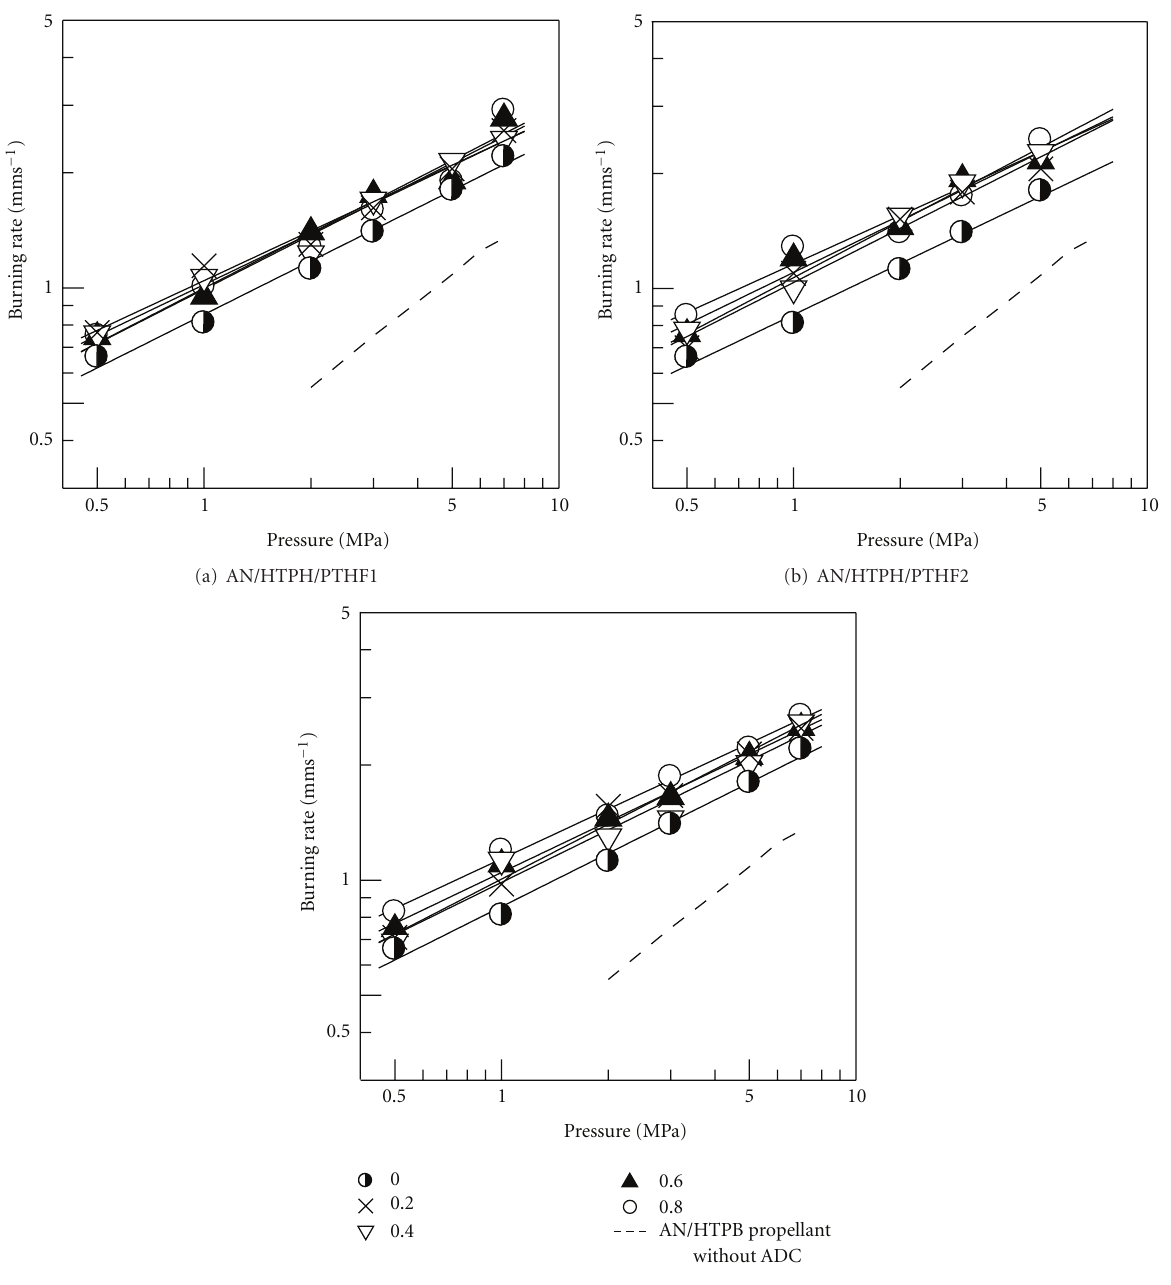
Figure 4: Burning rate characteristics of propellants with ADC.